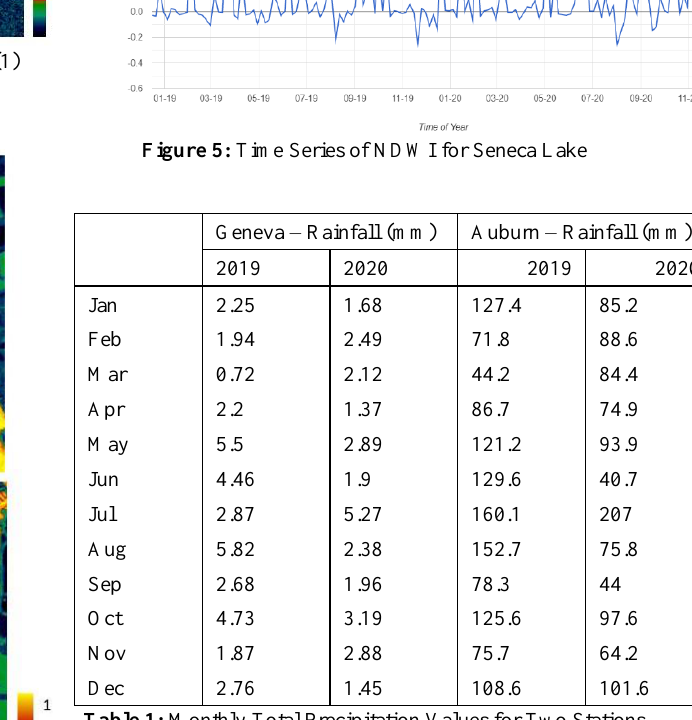
Table 1: Monthly Total Precipitation Values for Two